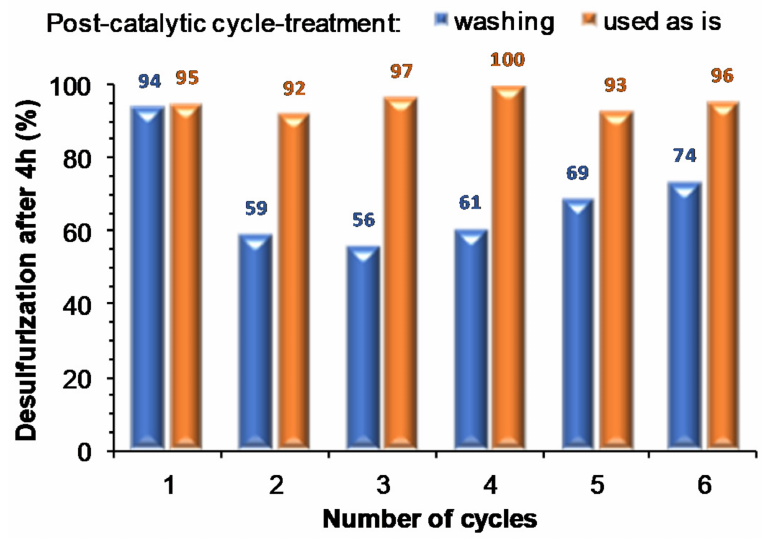
Figure 9. Desulfurization results obtained (after 4 h) for consecutive recycling ECODS cycles, catalyzed by the UAV-59@PMMA membrane (containing 0.02 mmol Gd), using 0.64 mmol of H 2 O 2 oxidant, 1:0.5 model diesel:[BMIM]PF 6 , at 70 ◦